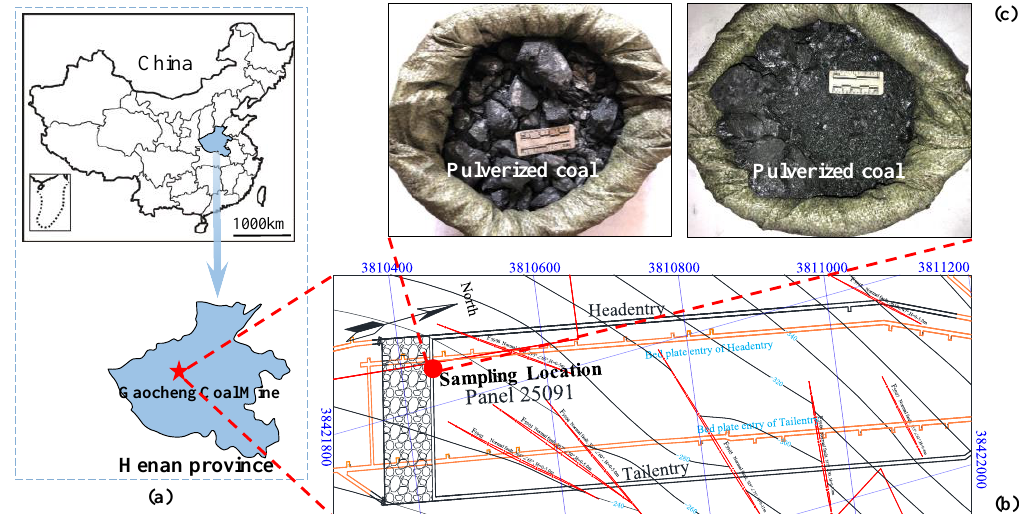
Figure 1. ( a ) The location of the Gaocheng coal mine; ( b ) the specific coal collection location in the Gaocheng coal mine; ( c ) the typical appearance of pulverized coal with an outburst property. Table 1. The natural coal particle size distribution of the No. II-1 coal seam in the Gaocheng coal mine after